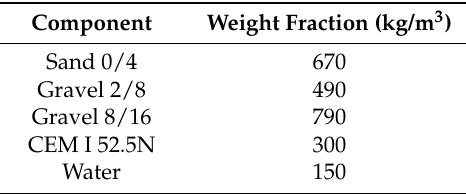
Table 4. Concrete composition.